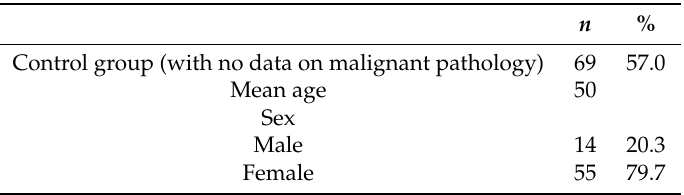
Table 2. Characteristics of the control set of